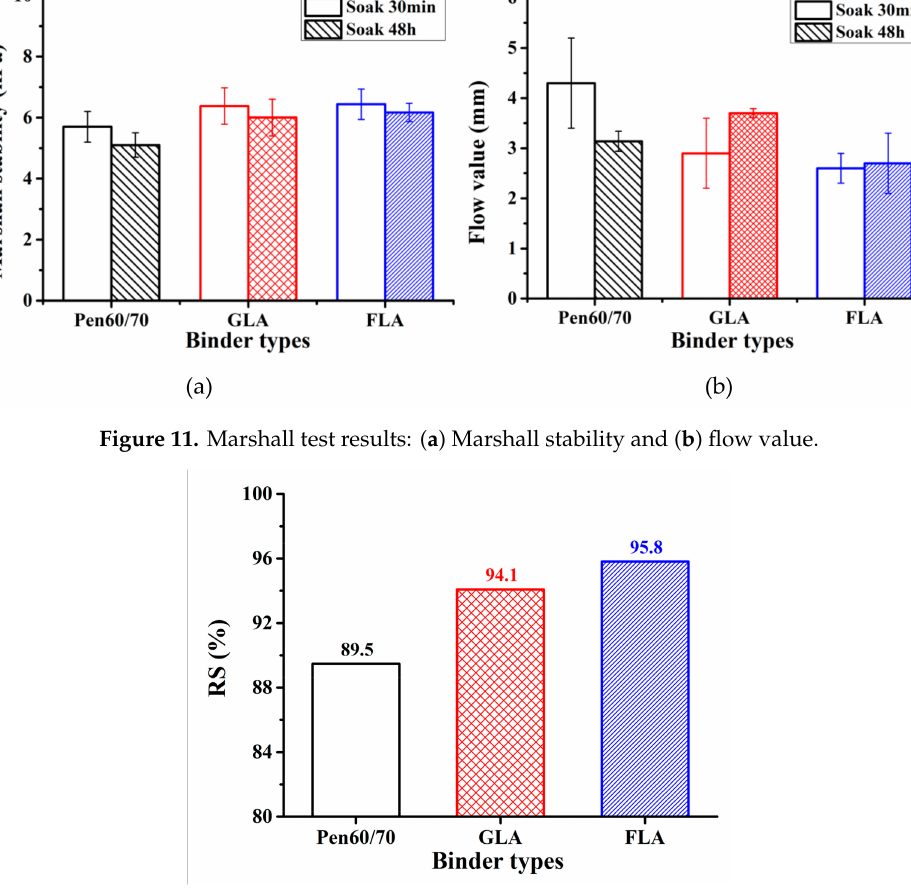
Figure 12. The residual Marshall stability (RS) of test samples. Table 7. The test results of Marshall stability and flow value